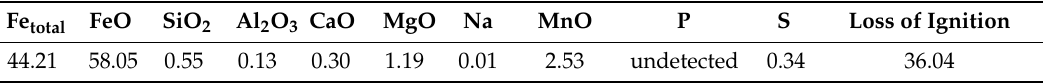
Table 1. Chemical composition of pure siderite mineral (in mass %).